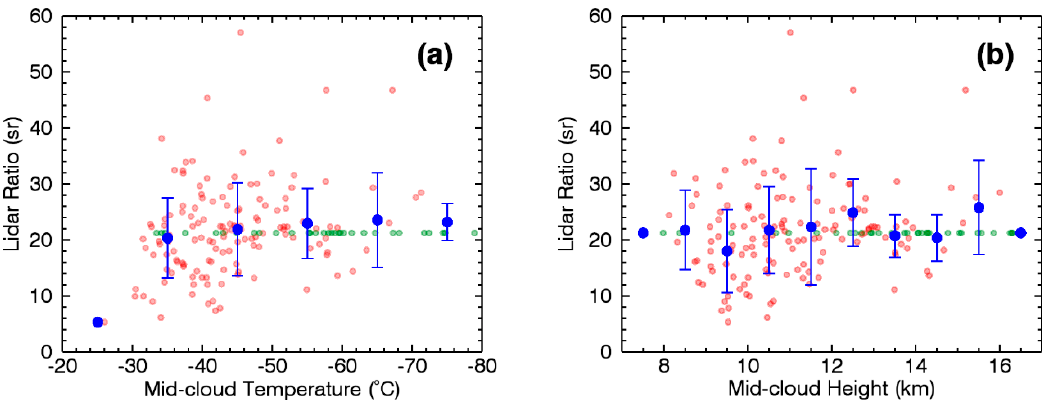
Figure 10. Scatterplots (red dots denote thin and dense cirrus clouds, green dots denote sub-visual cirrus clouds whose lidar ratios are set as ~21 sr manually) showing the relationships between cirrus lidar ratio and ( a ) mid-cloud temperature and ( b ) mid-cloud height. Blue dots and vertical bars are the associated mean values and standard derivation grouped in every 10 °C and 1 km respectively.